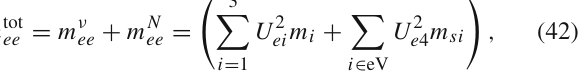
contributions are displayed by red dots band while the IH contribu- tions are given by blue dots. The vertical shaded area is for constraint on the sum of light neutrino masses from recent cosmological data (PLANCK1 and PLANCK2). The horizontal shaded areas are for the limits in effective Majorana mass parameter and half-life by GERDA and EXO+KamLAND-Zen